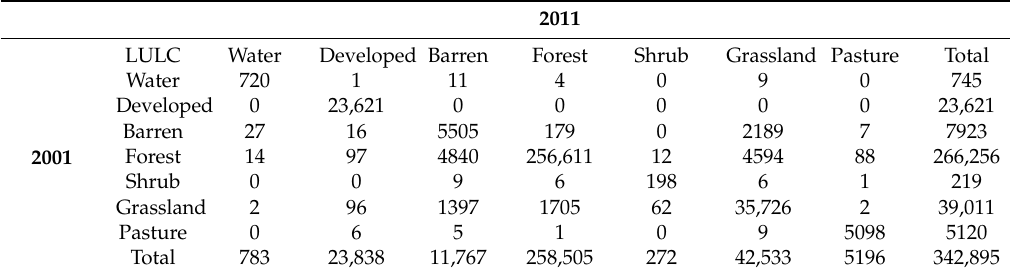
Table 3. Size of area that has experienced transition from one land cover category to another between 2001 and 2011 (unit, hectares) in the North Fork Kentucky River (NFKR) watershed.